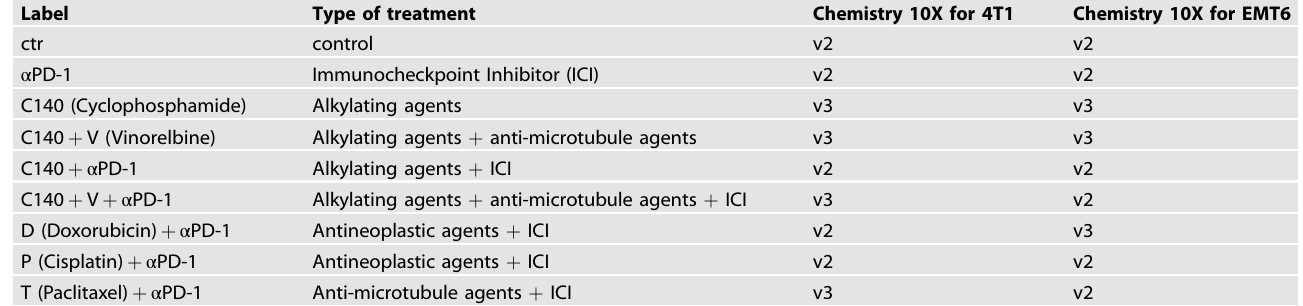
Table 1. Condition